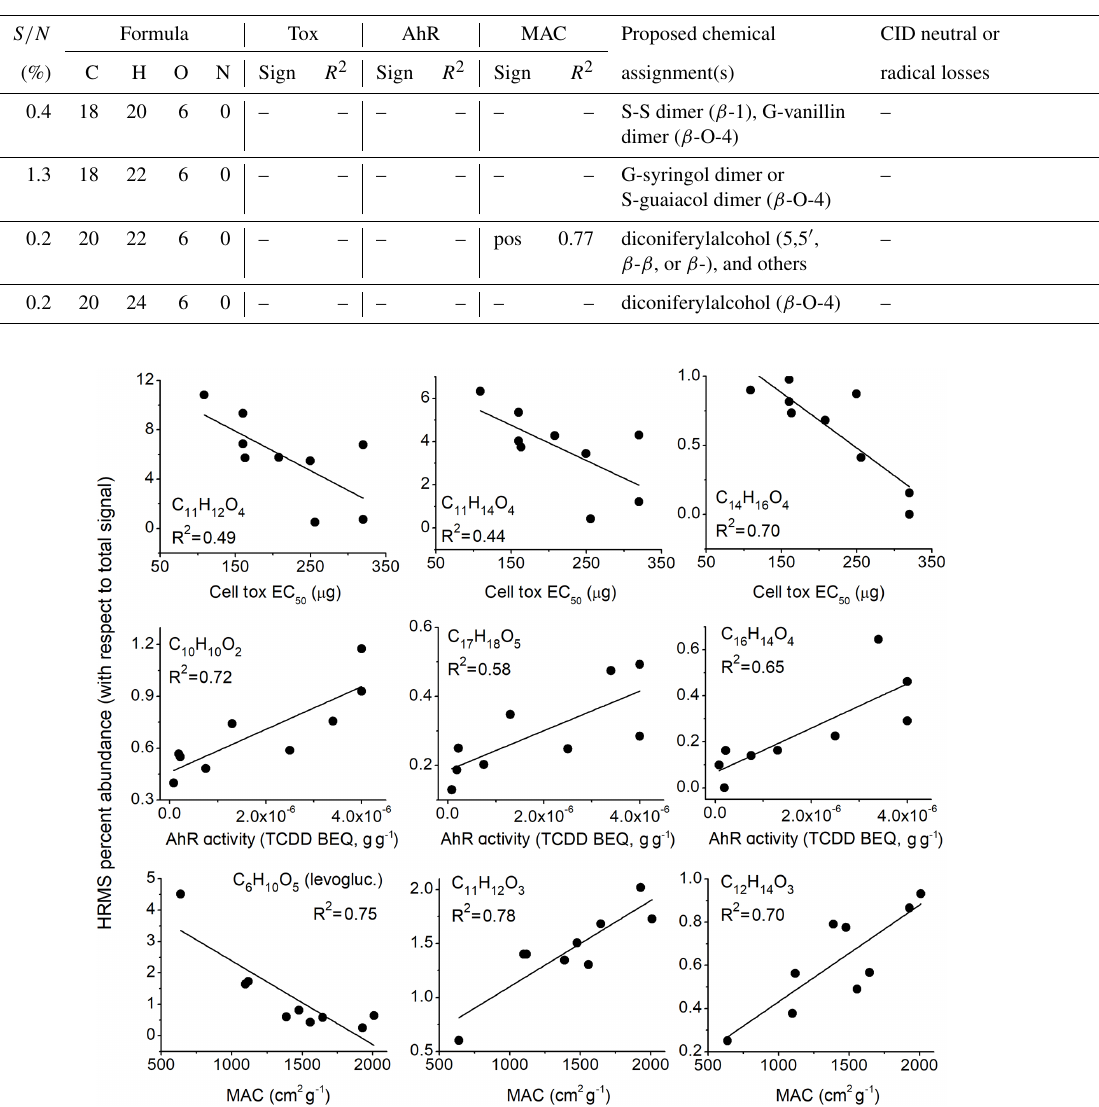
Figure 5. Select correlations of HRMS peaks with cell toxicity EC 50 , AhR activity, and MAC vis . Linear fits and correlation coefficients are shown. Proposed chemical identities are listed in Table